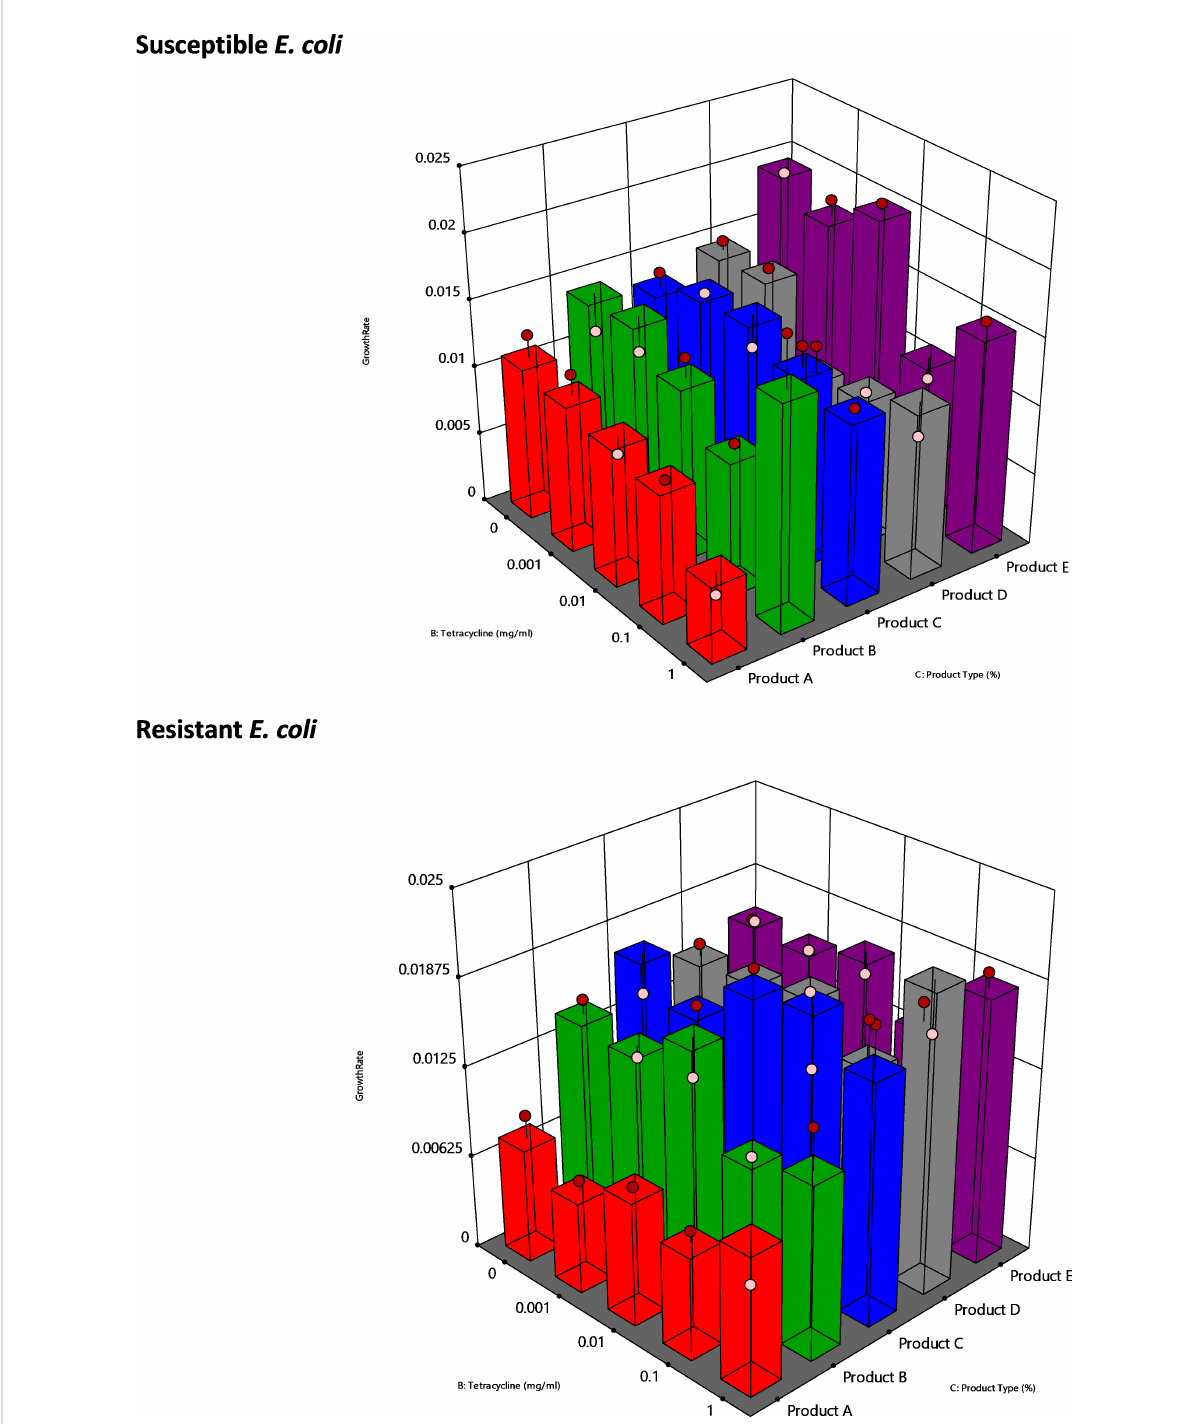
FIGURE 1 3D Surface graphs of growth rate, product type and antibiotic concentration generated by analysing bacterial growth rate data using DOE assessment. Susceptible (top) and resistant (bottom) E. coli were grown in the presence of 0.01% w/v of product. Tetracycline concentrations tested ranged from 0mg/ml to 1mg/ml. Height of each bar is a predicted value based on the conditions of the experiment. Pink and Red dots represent observed data. Bar colour is representative of product type. For both susceptible and resistant E. coli experiments Product Type was a signi fi cant factor, with p-values of p<0.0001 and p<0.0001 respectively. Product A = YPPA, Product B = YPPB, Product C = YPPC. Product D = Mannose, Product E =